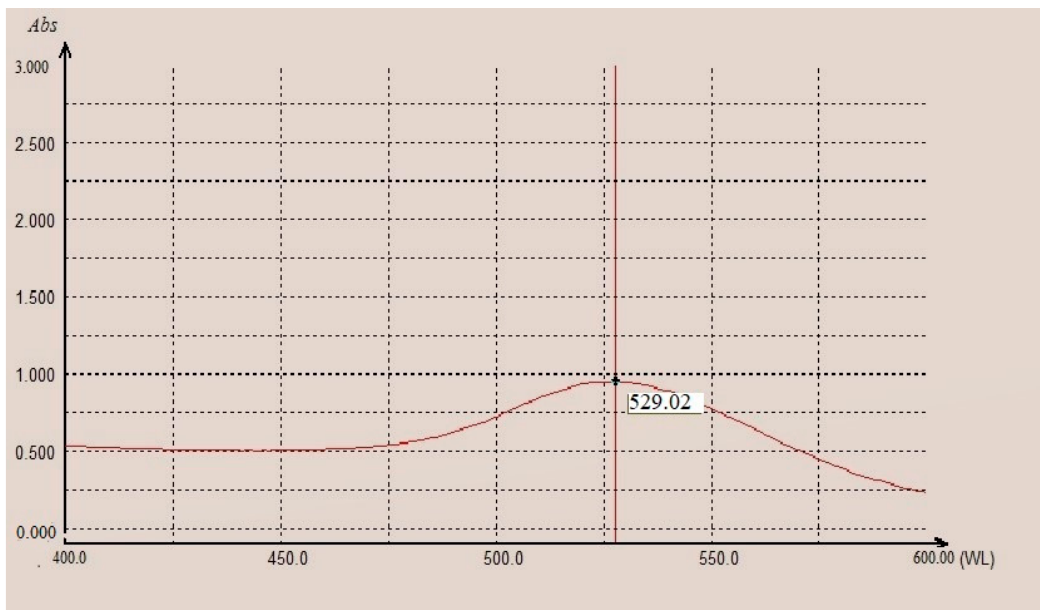
Figure 2. Spectrophotometer curve for 40 nm colloidal gold nanoparticles.